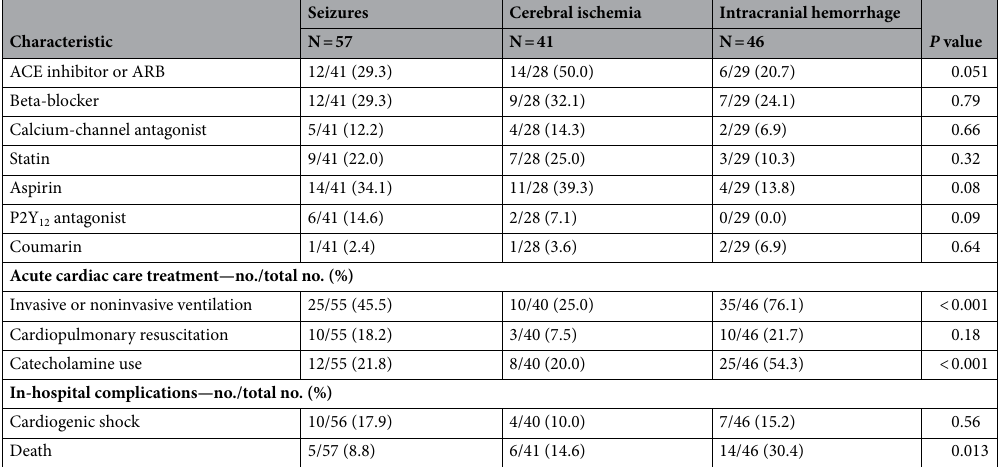
Table 5. Characteristics of Takotsubo patients stratified by neurological disorders. Analysis excludes patients who had overlap of 2 neurological disorders: focal onset seizure and ischemic stroke (N = 2), generalized onset seizure and posterior reversible encephalopathy syndrome (N = 2), status epilepticus and posterior reversible encephalopathy syndrome (N = 1), status epilepticus and subarachnoid hemorrhage (N = 1) and generalized onset seizure and subarachnoid hemorrhage (N = 1). ACE Angiotensin-converting-enzyme, ARB Angiotensin- receptor blocker, BNP Brain natriuretic peptide, COPD Chronic obstructive pulmonary disease, CRP c-reactive protein, ECG Electrocardiogram, IQR Interquartile range, QTc QT interval corrected for heart rate, SD Standard deviation, ULN Upper limit of the normal, WBC white blood cell count. °Including upper limits of the normal range for troponin T, high-sensitivity troponin T, and troponin I. † Including upper limits of the normal range for brain natriuretic peptide and the N-terminal of prohormone brain natriuretic peptide. ‡ Data